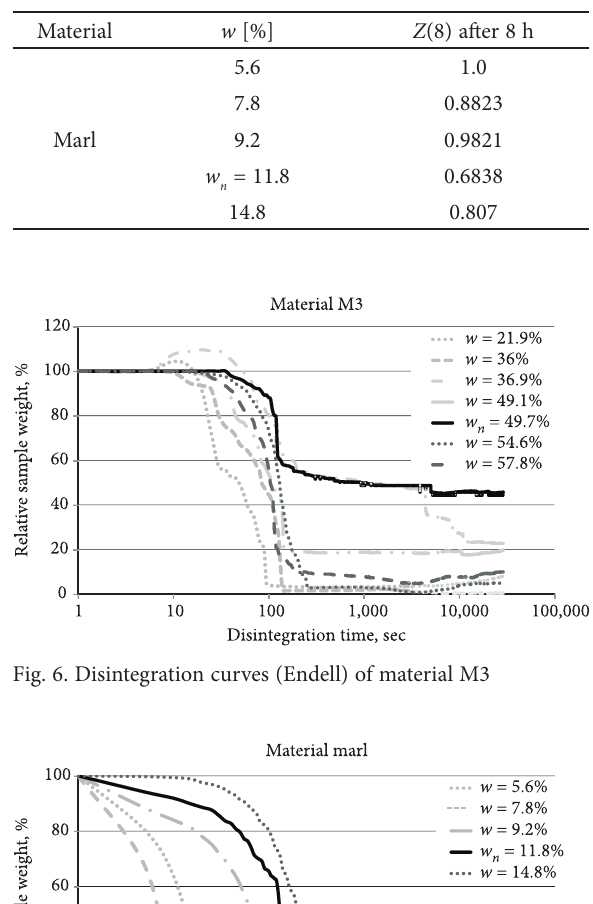
Table 7. Disintegration number z(8) of marl